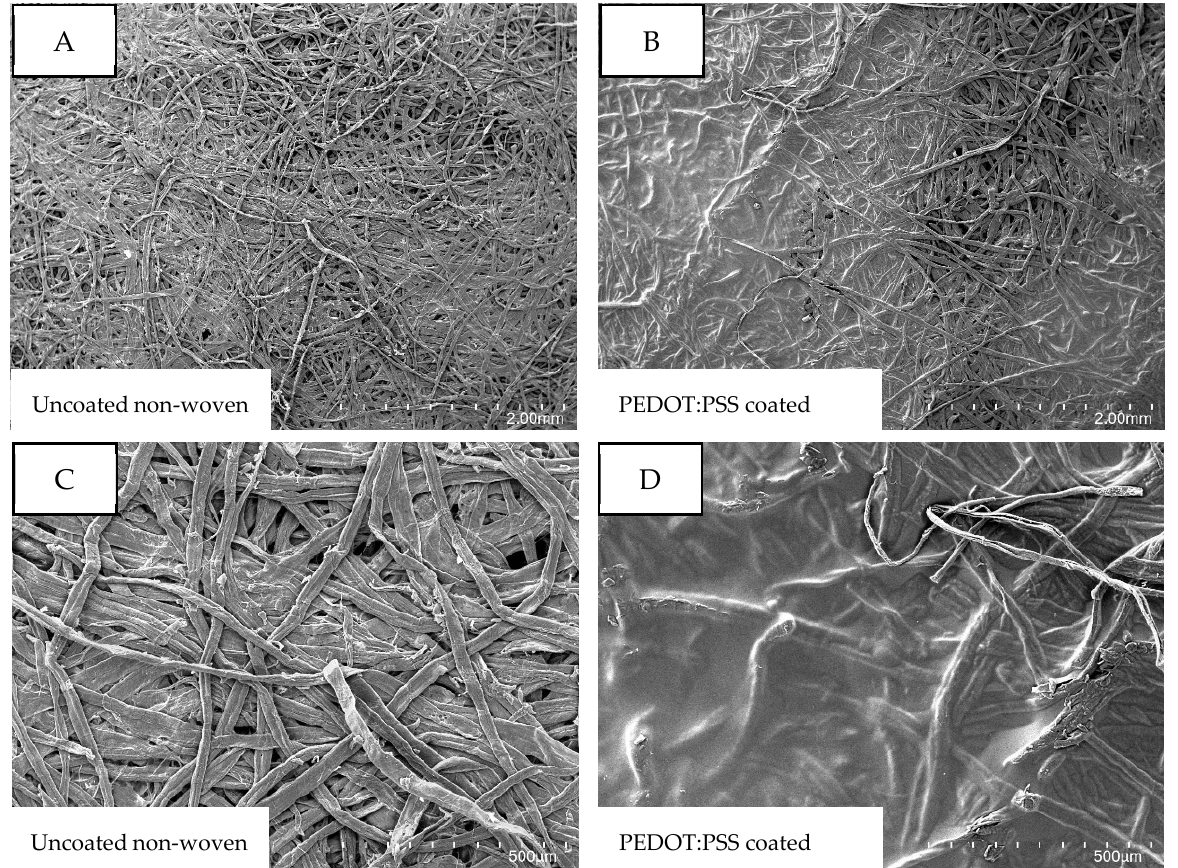
Figure 3. SEM images of ( A , C ) uncoated and ( B , D ) PEDOT:PSS-coated nonwoven material. ( A , B ): 25 times magnification. ( C , D ): 100 times magnification.